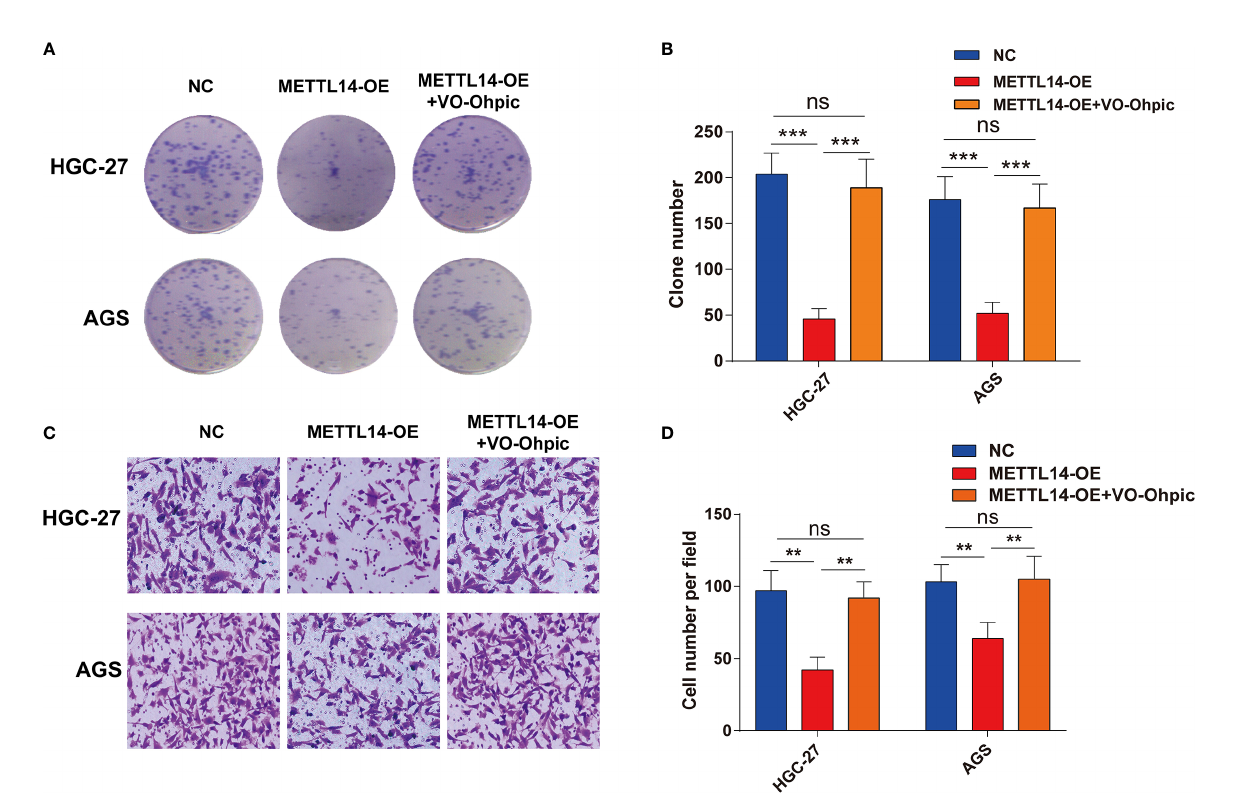
FIGURE 5 | METTL14 inhibits STAD cells proliferation and invasion via regulation of PTEN. (A , B) METTL14 overexpression inhibits HGC-27 and AGS cells growth, and targeting PTEN by VO-Ohpic antagonized the effect of METTL14 inhibiting the growth of HGC-27 and AGS cells. (C , D) METTL14 overexpression inhibits HGC- 27 and AGS cells invasion. When METTL14 overexpression and treatment of VO-Ohpic in HGC-27 and AGS cells, the invasive abilities of HGC-27 and AGS cells after METTL14 overexpression was enhanced by VO-Ohpic. (**P < 0.01; ***P < 0.001; ns, no signi fi cant